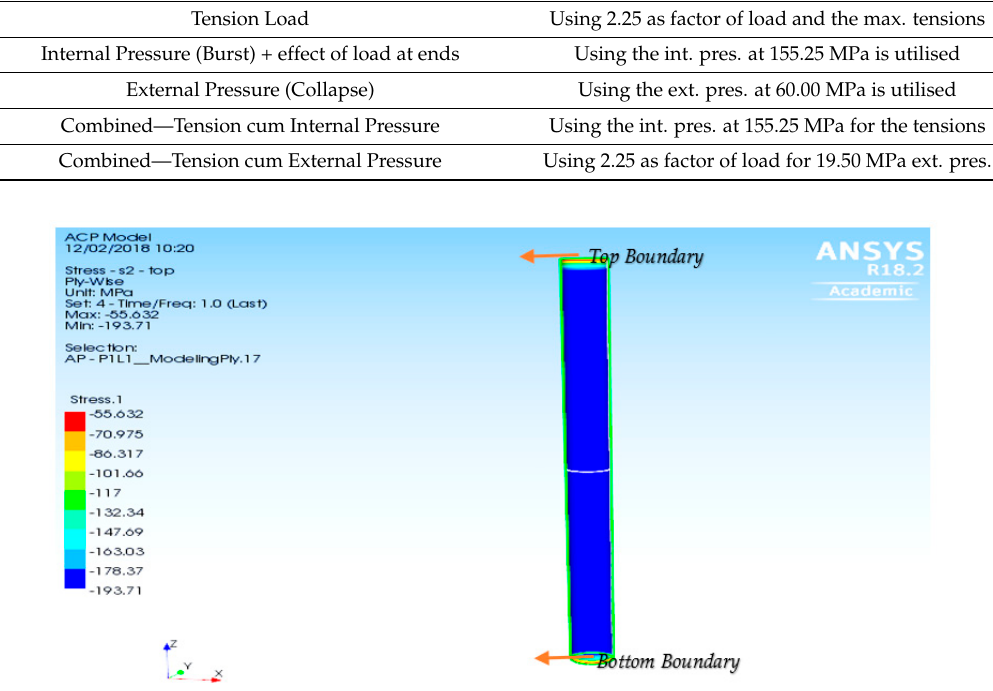
Figure 5. Stress result for ply 17 in ANSYS ACP. Table 5. The design loadings for modelling the composite riser.